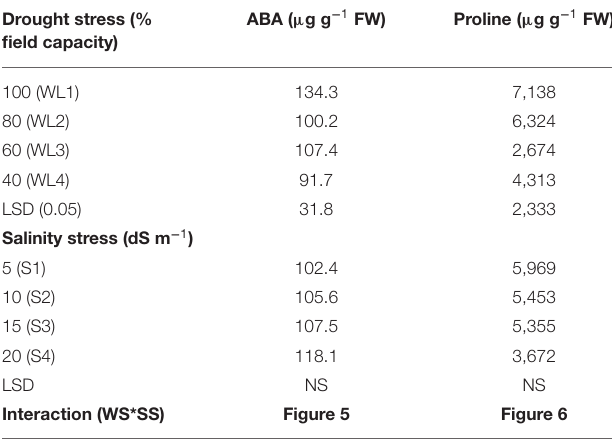
Meanswithdifferentlettersineachcategoryaresignificantlydifferentat α = 0.05.NS,WS, SS, and LSD stand for no significant, drought stress, salinity stress and least significant difference, respectively. The * symbol indicates the interaction.